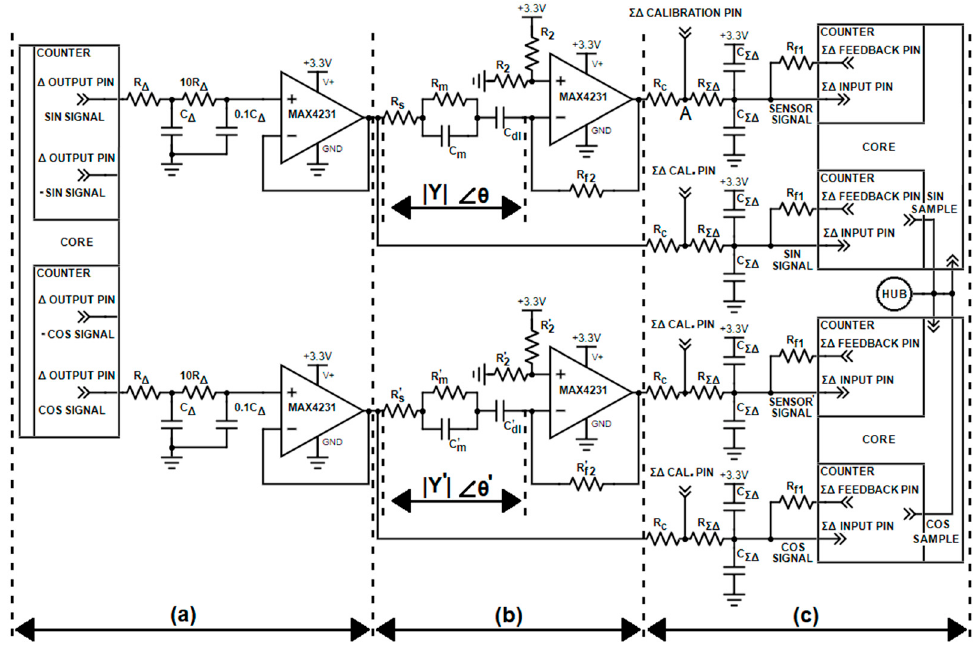
Figure 17. Block diagram for a two-channel Frequency Response Analyzer (FRA) using a single core as signal generator. Electronics 2018 , 7 , x FOR PEER REVIEW